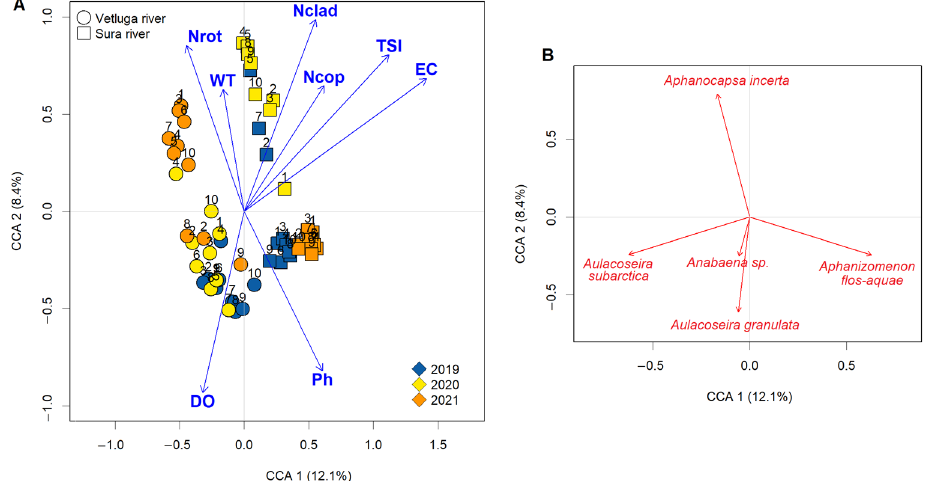
Figure 5. Phytoplankton communities’ CCA ordination plots (( A )—samples and factors; ( B )—dominant zooplankton species). The decoding of the factors is presented in Table 4.